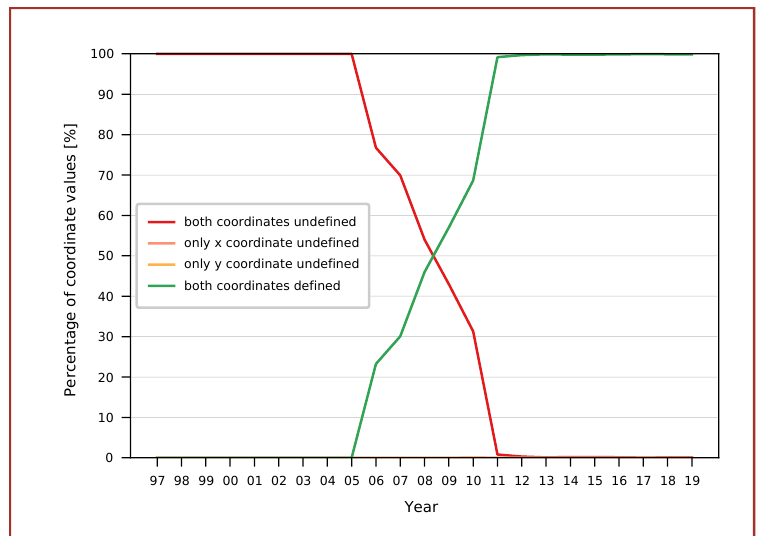
Figure 1. Wildland fire coordinate logging. The graph depicts the percentage of logged coordinate values from all wildland fires in a given